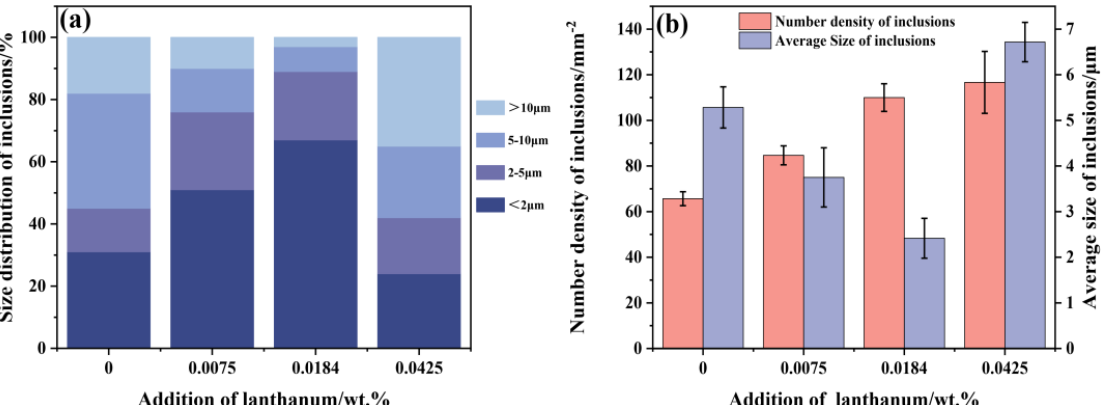
Figure 5. Size distribution ( a ) and number density and average size ( b ) of inclusions in four steels with different La content additions.